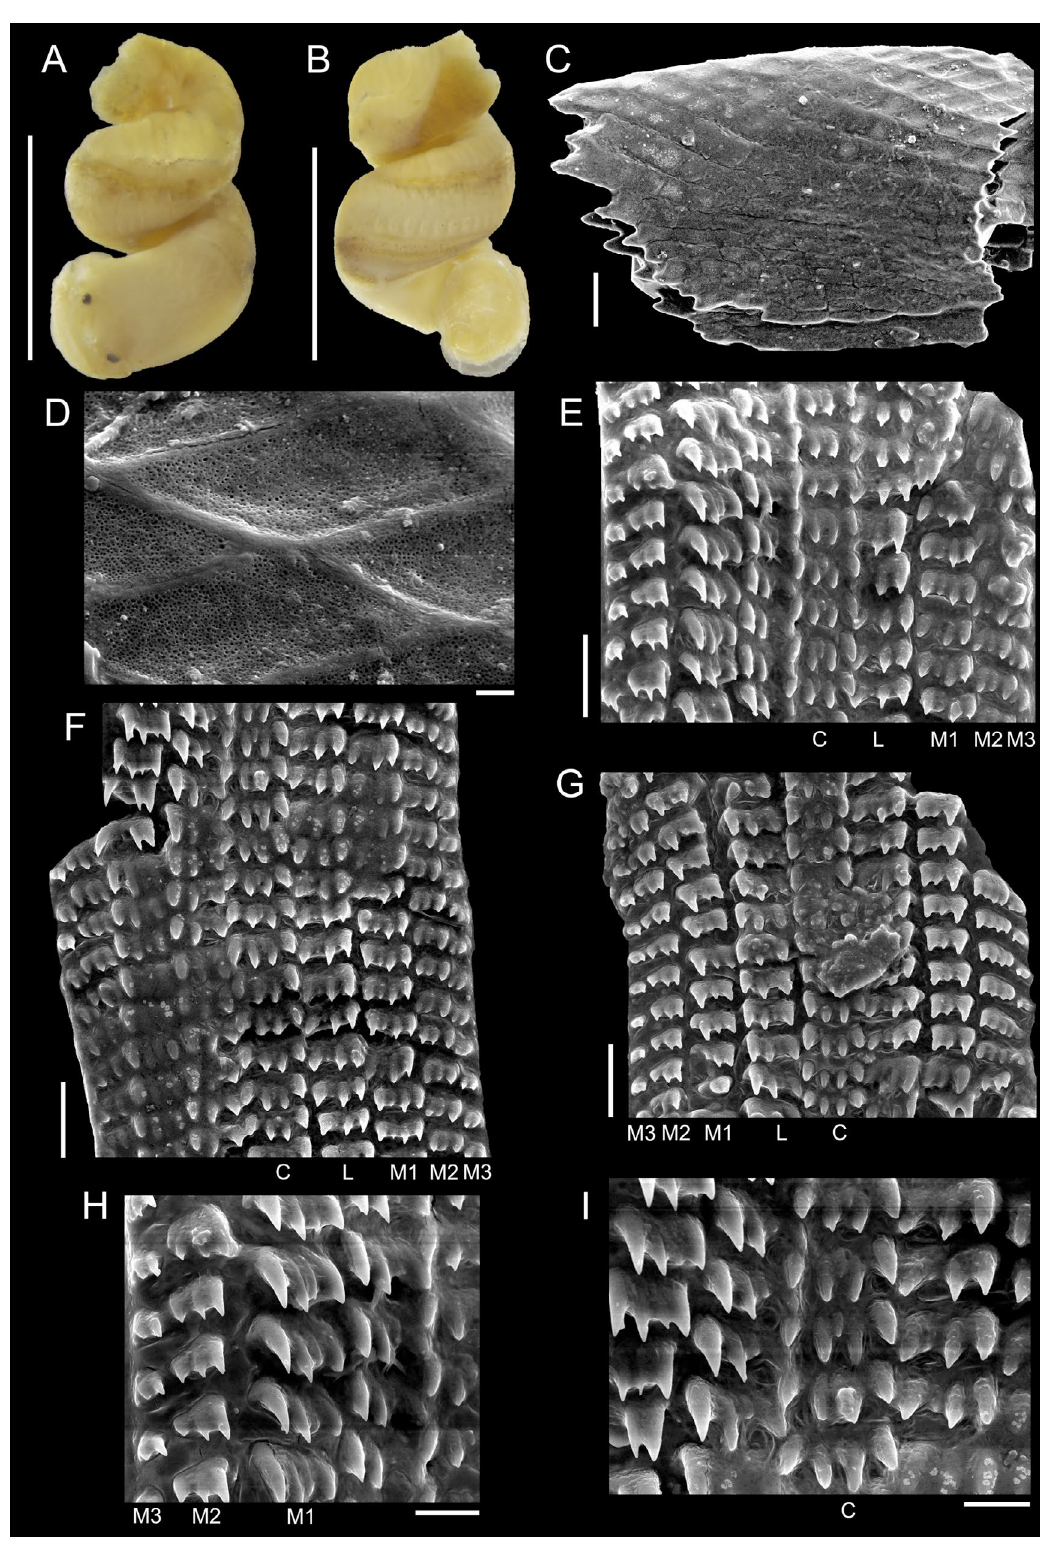
Fig. 4. Metaxia rugulosa (C.B. Adams, 1850). A–I . BMSM 56034. A–B . External morphology. C–D . Jaw, outer side. E–I . Radula. Scale bars: A–B = 1 mm; C = 20 µm; D = 2 µm; E–G = 10 µm; H–I = 5